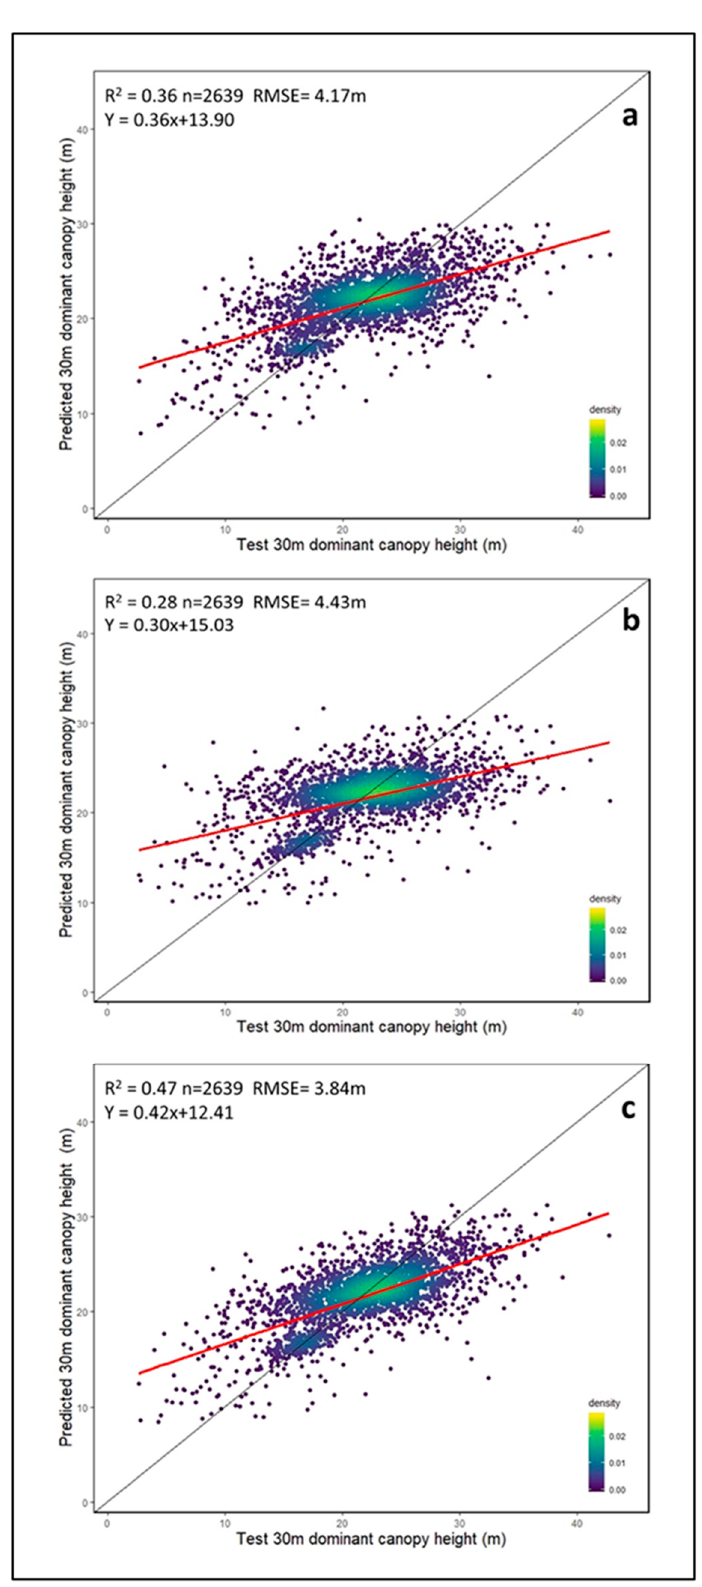
Figure 5. Scatterplots comparing the 30 m dominant canopy heights of the 2639 test pixels and the random forest regression tree predicted values. Results shown for the regression trees derived using predictor variables from ( a ) the dry season July 14th 2013 Landsat-8 OLI image, ( b ) the wet season December 8th 2014 Landsat-8 OLI image, and ( c ) both images. The point densities, calculated using a 100 × 100 quantization of the plot axes, are displayed with a rainbow color scale.